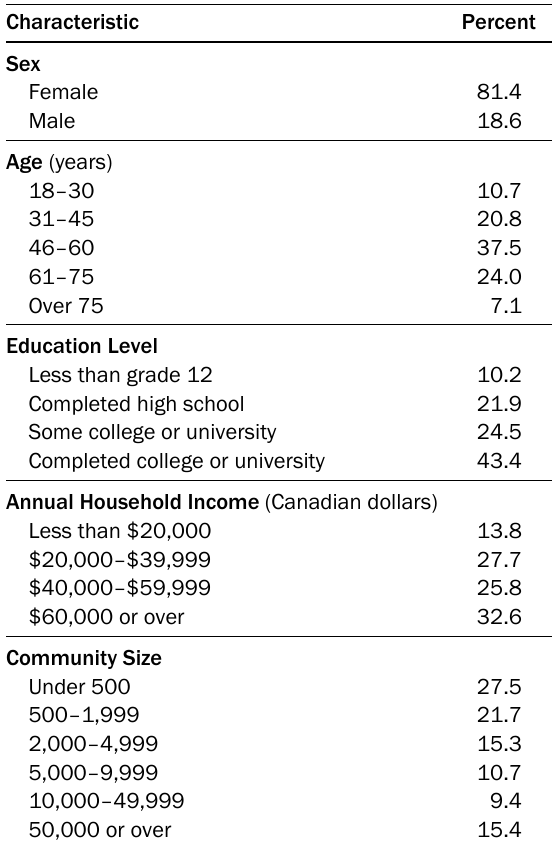
Table 1. Characteristics of Survey Respondents Table 3. Geographic Area from Which